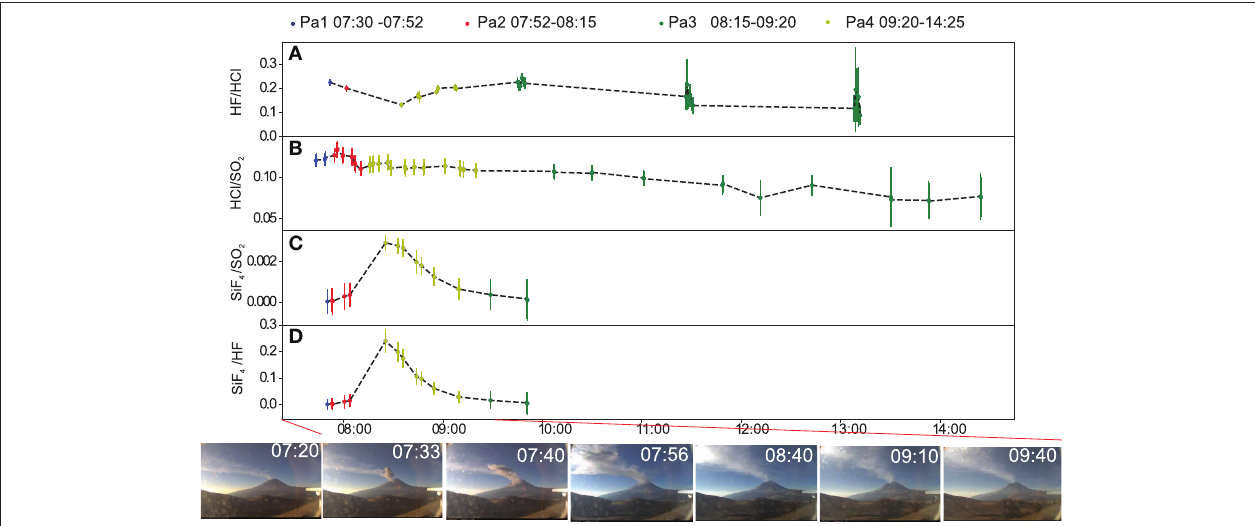
FIGURE 5 | Time series of (A) HF/HCl, (B) HCl/SO 2 , and (C) SiF 4 /SO 2 ratios acquired on March 6th, 2015 at Popocatépetl volcano. The time axis corresponds to the measurement time, where the plume of the 07:30 a.m. explosion was measured at 07:54. The different colors correspond to the different periods mentioned in the